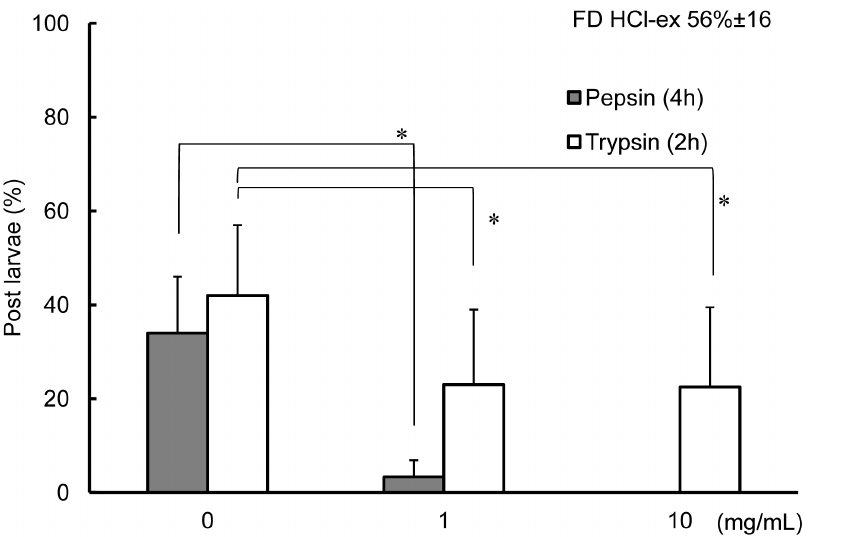
Figure 6. Percentages of post larvae on pepsin and trypsin treated FD HCl-ex of C.gigas SC. Shaded and open boxes represent pepsin and trypsin treated experiments, respectively. Data are means of 9 replicates and error bars represent standard deviations (SD). Lines connected groups that were compared using Wald test. Asterisks * indicate significantly different groups (p , 0.05).